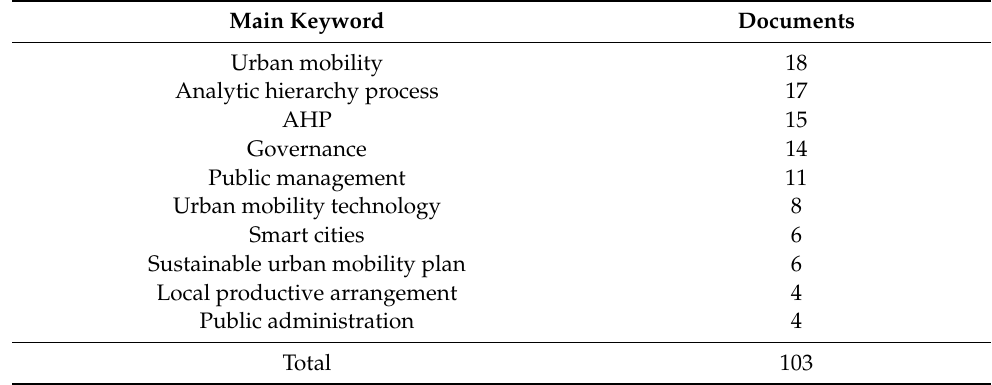
Table 2. Selection of documents.